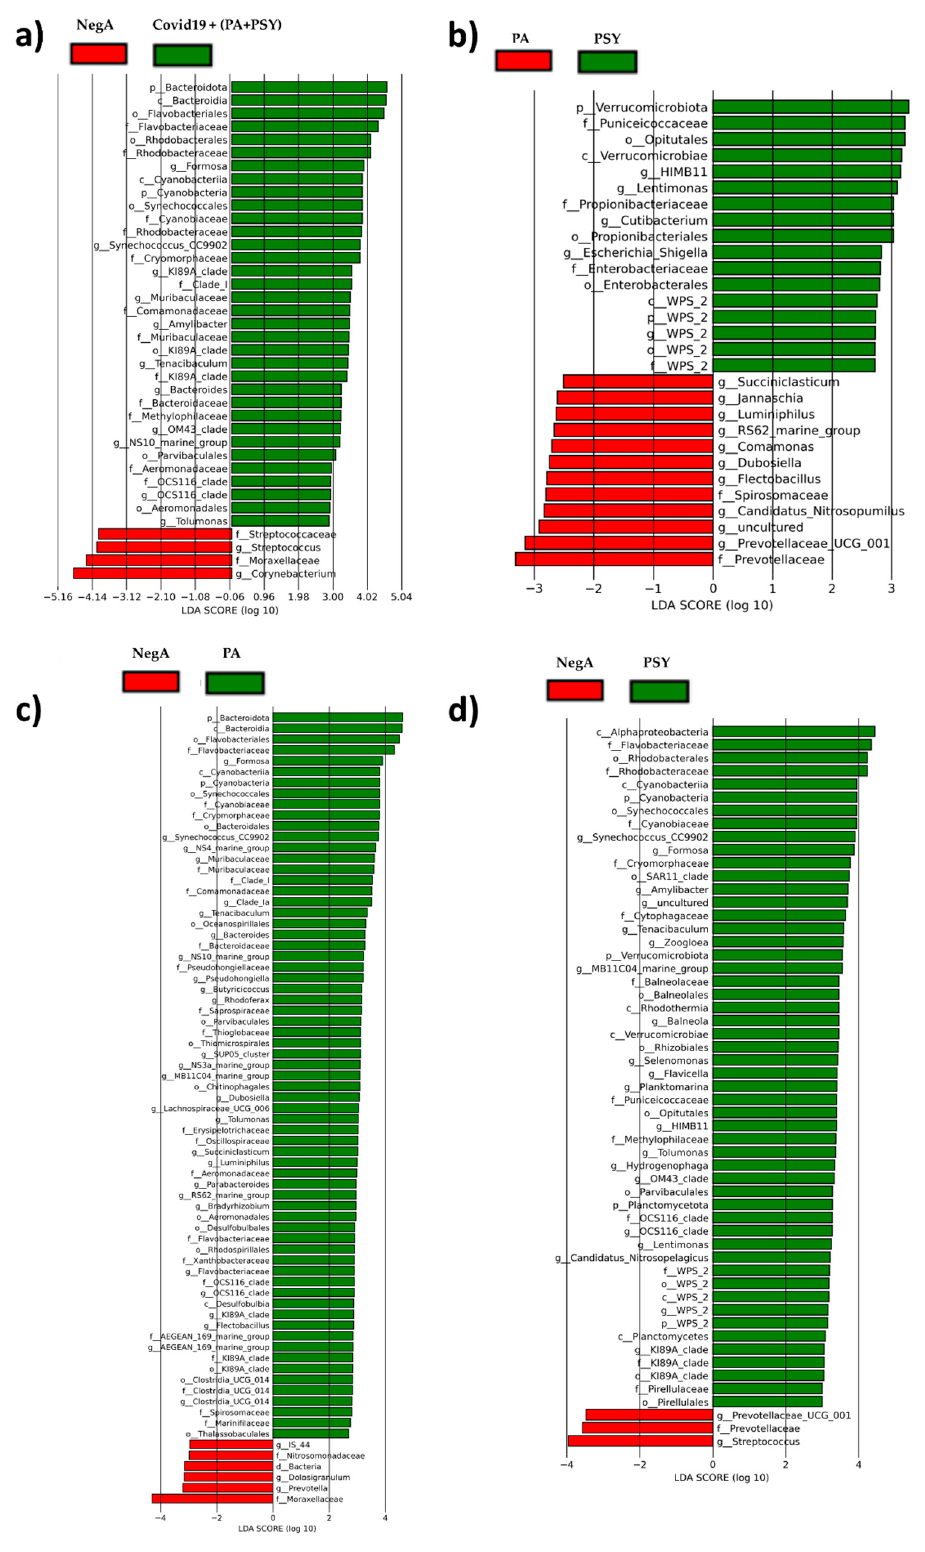
Figure 4. Histogram of the linear discriminant analysis (LDA) scores for differentially abundant taxonomic features between ( a ) NegA (COVID-19 –ve) (red) and COVID-19 +ve (PSA and PA) (green), ( b ) PA (red) and PSA (green), ( c ) NegA (COVID-19 –ve) (red) and PA (green), and ( d ) NegA (COVID-19 –ve) (red) and PSA (green). The threshold on the logarithmic LDA score for discriminative features was set to 2.0 for LEfSe analysis.